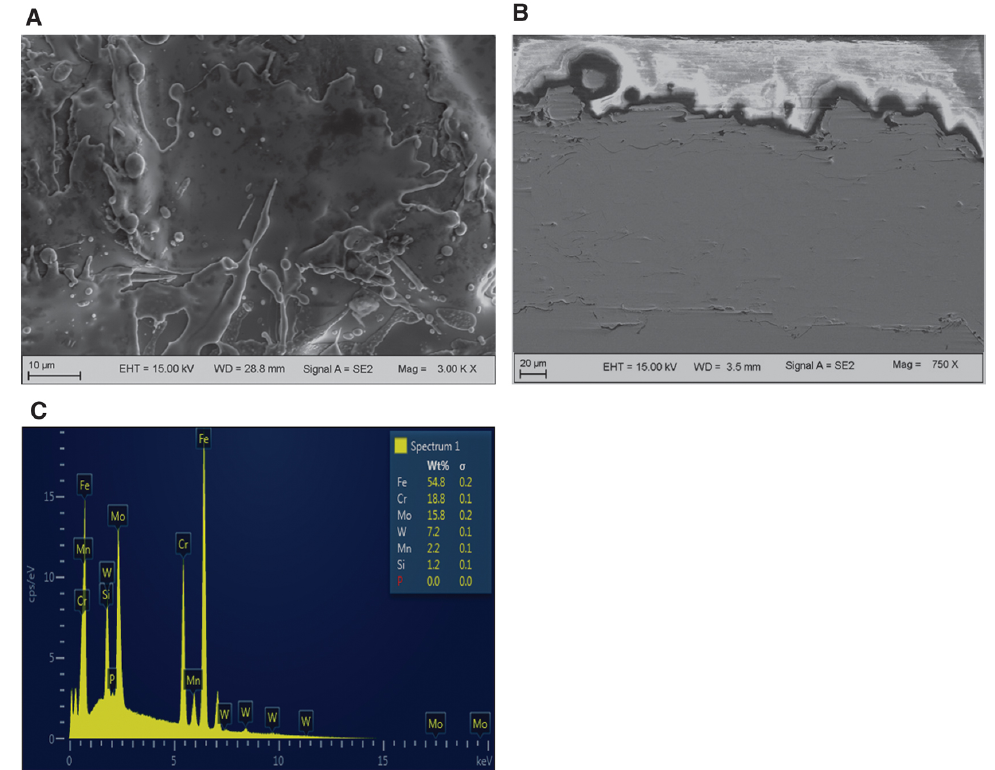
Figure 5: SEM micrograph of the coating deposited using optimised HVOF spray